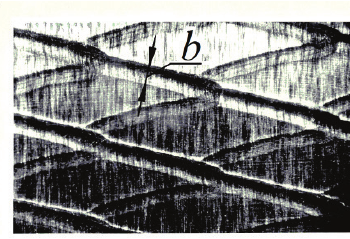
Figure 3. Fields of friction regimes on Stribeck curve due to change of slip velocity